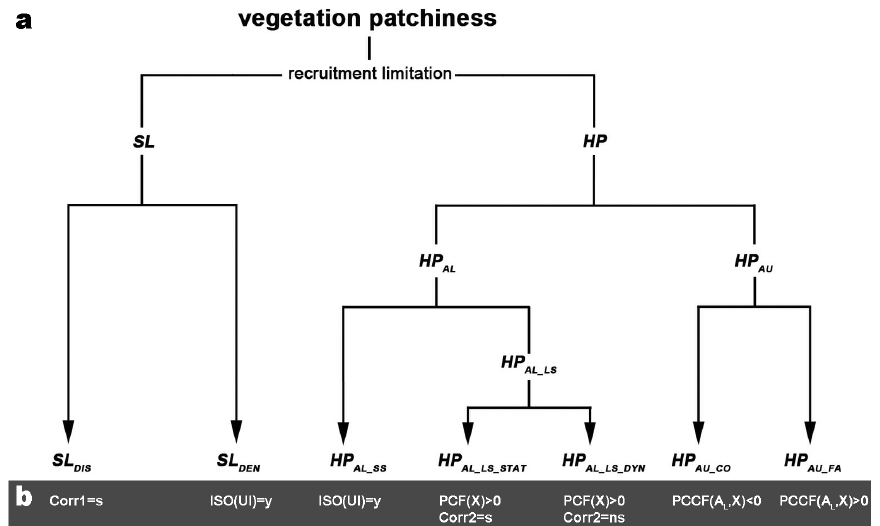
Figure 1. Schematic overview of the proposed hypotheses on R.Stricta recruitment dynamics, organized in a framework (subfigure a), together with their expected vegetation pattern characteristics (subfigure b). SL stands for seed limitation, HP for habitat patchiness, SL DEN for density SL, SL DIS for distance SL, HP AL for allogenic HP, HP AL_SS for small-scale allogenic HP, HP AL_LS for large-scale allogenic HP, HP AL_LS_STAT for static large-scale allogenic HP, HP AL_LS_DYN for dynamic large-scale allogenic HP, HP AU for autogenic HP, HP AU_CO for competition, and HP AU_FA for facilitation. ISO(UI)=y signifies that unbranched individuals occur isolated, PCF(X) . 0 denotes that the evaluated PCF lies significantly ( p , 0.01) above the corresponding null model envelope (X representing the cohort under evaluation). PCCF(A L ,X) , 0 and PCCF(A L ,X) . 0 respectively indicate that the evaluated PCCF lies significantly ( p , 0.01) under and above the corresponding null model envelope (X and A L respectively standing for a cohort other than the large adults, and the large adult cohort, between which PCCFs are being calculated). Corr1=s denotes whether adult FVC spatially correlates significantly ( p , 0.05) with unbranched individual density. Corr2=s or Corr2=ns respectively mark whether the spatial correlations between densities of different cohorts are significant ( p , 0.05) or